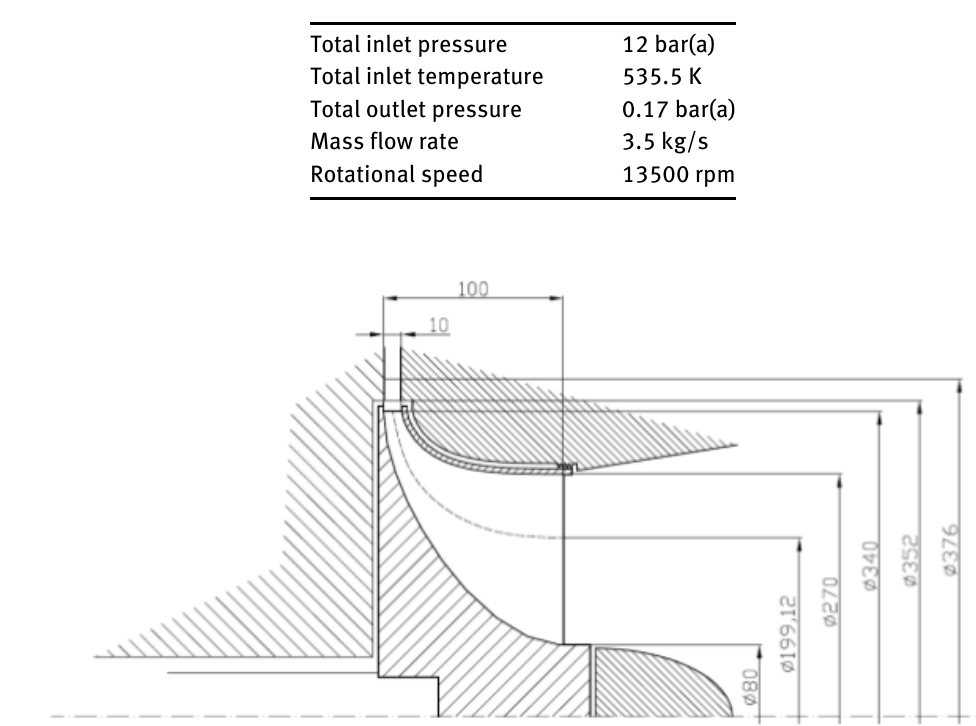
Figure 7: Main dimensions of the centripetal turbine stage.